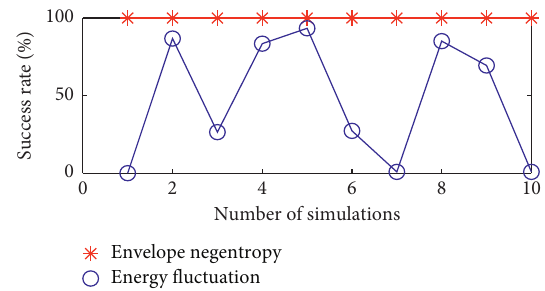
Figure 8: Success rates of the proposed method and EFS on the simulated signal in Figure 6(b). Table 3: The mean and variance of success rate for different indices with SNR � −